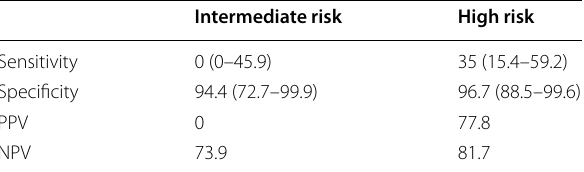
Table 5 Sensitivity, specificity, positive predictive value (PPV) and negative predictive value (NPV) for prediction of lymph node metastases by PET/CT (95% confidence interval)